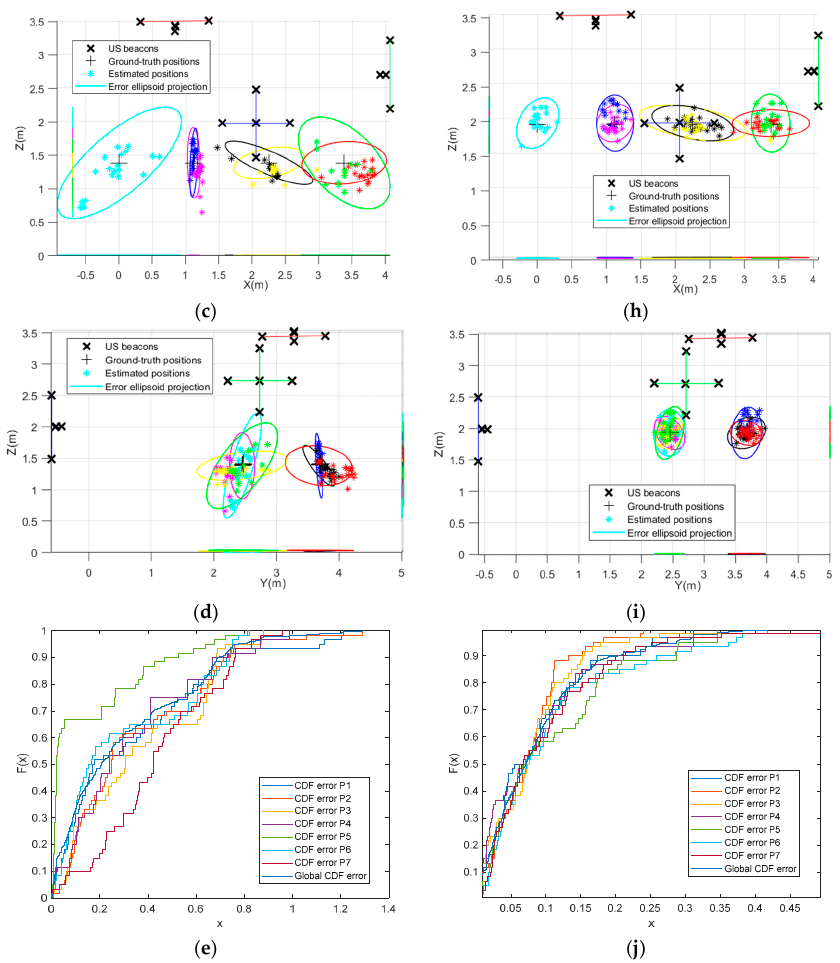
Figure 12. Experimental results for the tested points P1–P7 for both heights, z 1 = 1.35 m on the left ( a – e ) and z 2 = 1.93 m on the right ( f – j ): successively, 3D representation of clouds of points; Y–X projections; Z–X projections; Z–Y projections; and experimental CDFs for each point after LKF fusion. Table 10. Mean errors and standard deviations of estimated positions when applying the LKF at z 1 =1.35 m and z 2 =1.93 m for the test points (P1–P7).